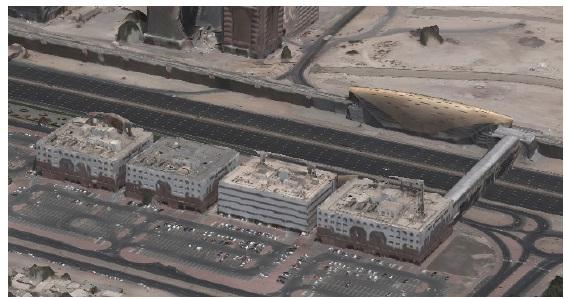
Figure 6. Textured Model Sample 2